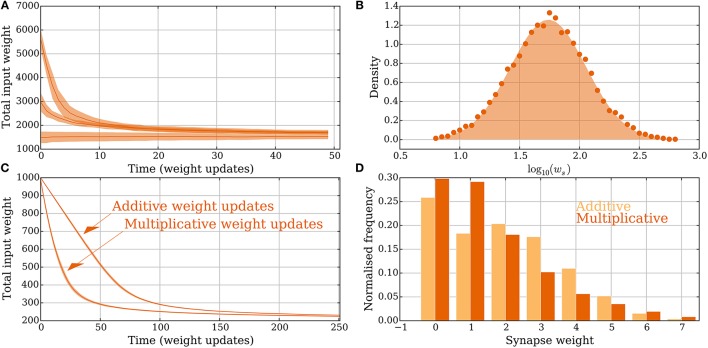
Heterogeneous and multimodal weights in the model without leak (Section 3.2.3). (A,B) Heterogeneous weights. (A) Input convergence with the spike threshold θv adapted to the synaptic weights. (B) Comparison between the distribution of strong synaptic weights (lognormal distribution, shaded) and the strong weights after convergence (dots). (C,D) Multimodal synapses. Two different weight update rules are presented: one additive and one multiplicative (see Section 2.5 for details). (C) Convergence for the two different setups where all the synapses start with weight 10 and θv is set to 100. (D) The input weight distributions are compared for the multimodal weight update rules in (C) after 250 extra weight updates. The additive weight update rule produces a bimodal weight distribution whereas the multiplicative one produces a unimodal distribution. None of the update rules imposes a hard upper bound on the weights and all resulting weights are less than 10, which was the starting weight of the synapses. For all panels, the parameters were chosen as in Table 1 unless otherwise specified. In (A,C) each curve is the mean of 30 and, respectively, 100 trials; the envelopes represent a standard deviation estimate. In (B) the distribution is obtained from 5.000 trials, where in each one 50 weight updates were simulated.